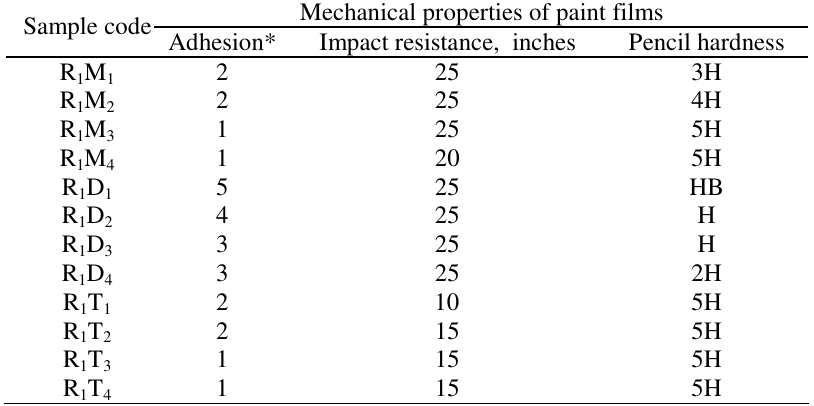
Table 2. The surface properties of the cured film of different blends